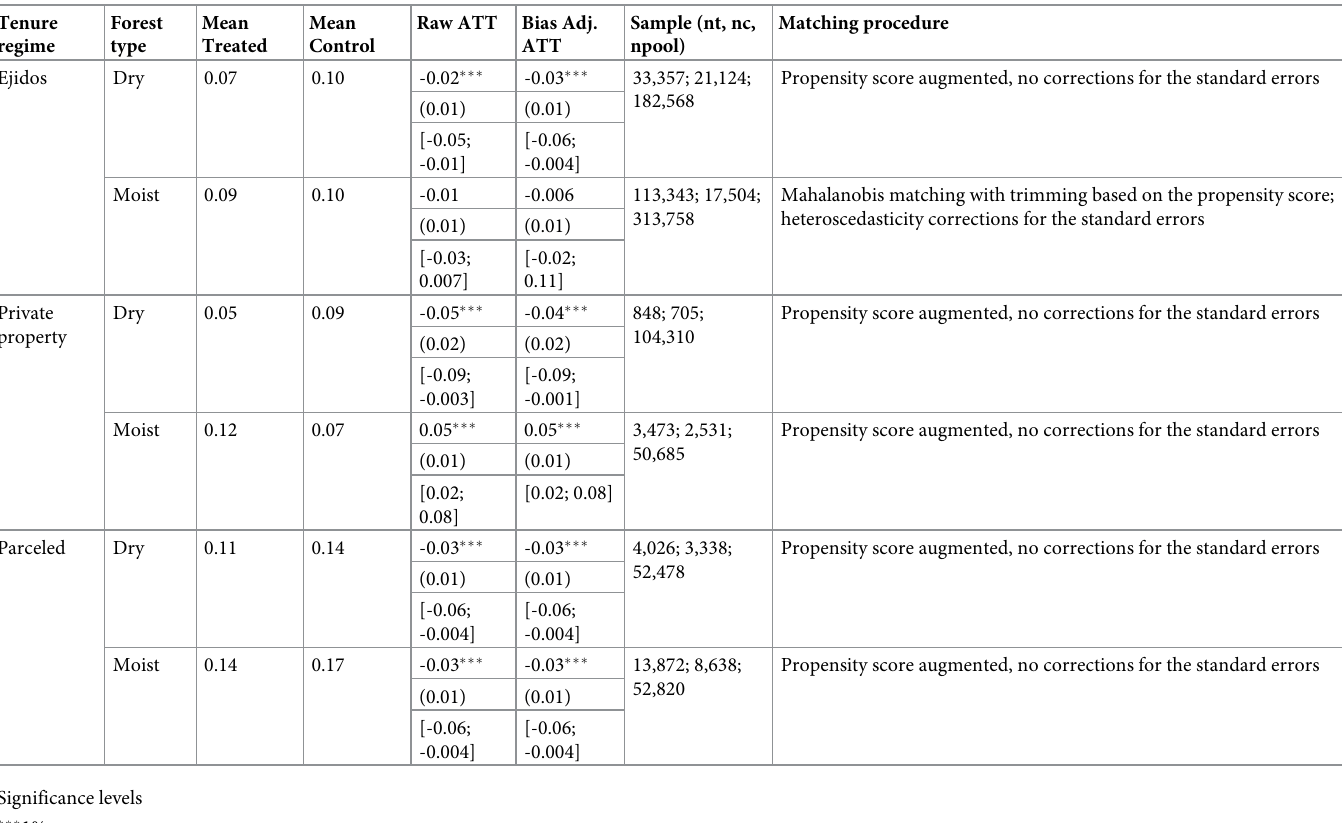
Table 5. Average spillover effects from protection proxied by the average treatment effect on the treated (ATT). The ATT captures the probability of forest loss in the unprotected portions of properties due to protection. In this case, a pixel is considered treated if it is within the unprotected portion of a protected property; the control group comprises of pixels located in fully unprotected properties. The standard errors are given in parentheses and confidence intervals corresponding to each significance level—in square brackets. n t , n mc , n cp indicate treated (on support), matched control, and control pool observations, respectively. A negative sign of the ATT indicates that protection reduced the probability of forest